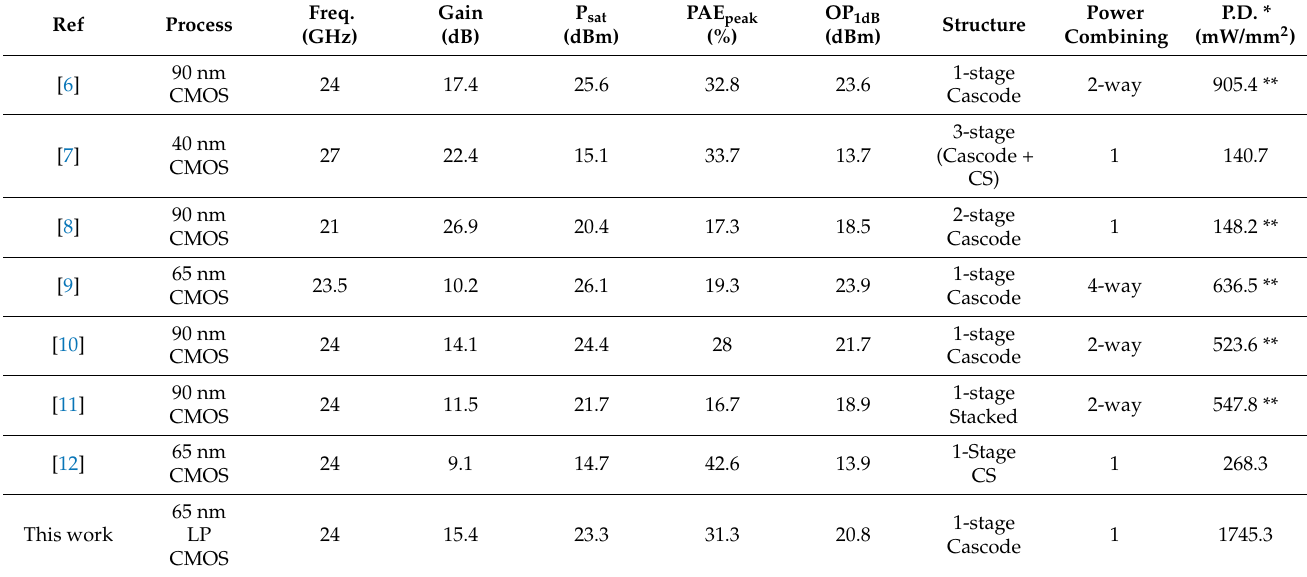
Figure 7. Measurement results of the proposed PA. ( a ) Measured and simulated S-parameters. ( b ) Measured large-signal characteristics with 1-tone signal at 24 GHz. ( c ) Measured large-signal characteristics vs. frequency of proposed PA. Performance comparison with recent state-of-art K-band CMOS PAs is shown in Table 1. Table 1. Performance comparison